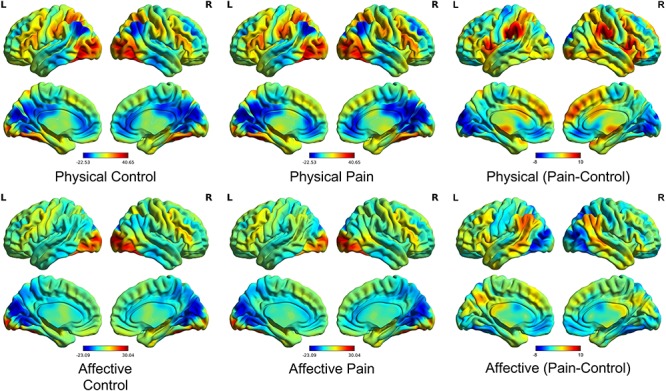
Activation maps (unthresholded) from the conventional GLM approach. The BOLD activation maps for each task condition (middle) as compared to baseline (left) or the relative subtraction contrasts between pain and control in physical and affective conditions, respectively (right).